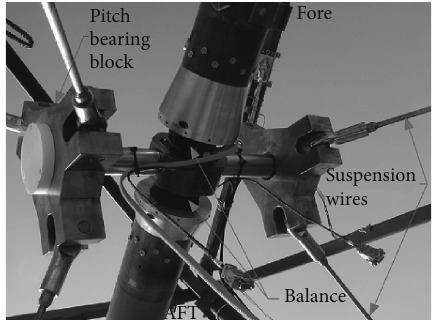
Figure 14: Improved six-wire suspension system